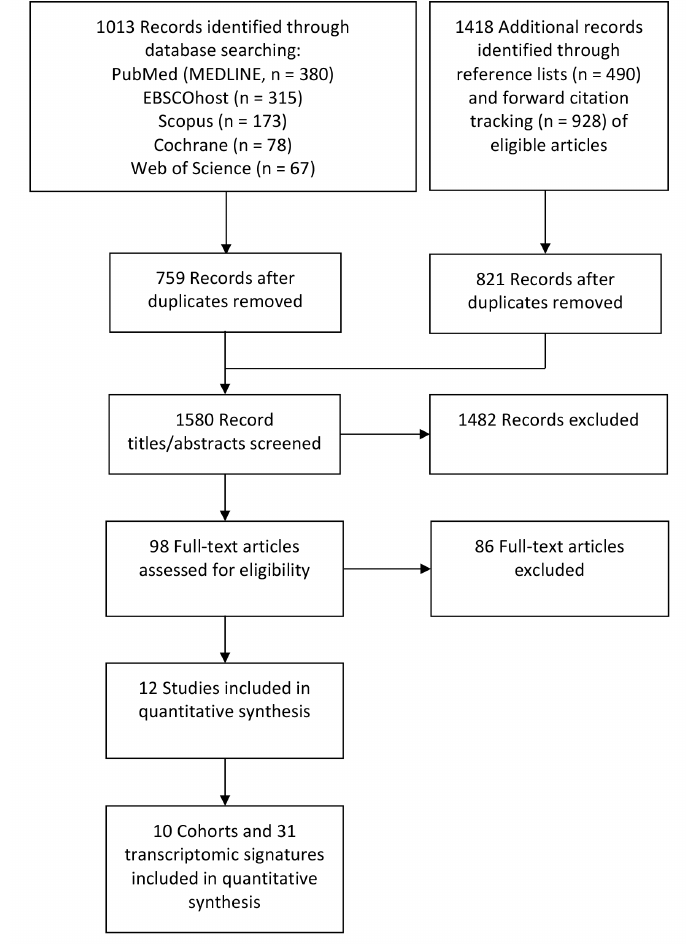
Figure 1. Preferred Reporting Items for Systematic Reviews and Meta-Analyses (PRISMA) flow